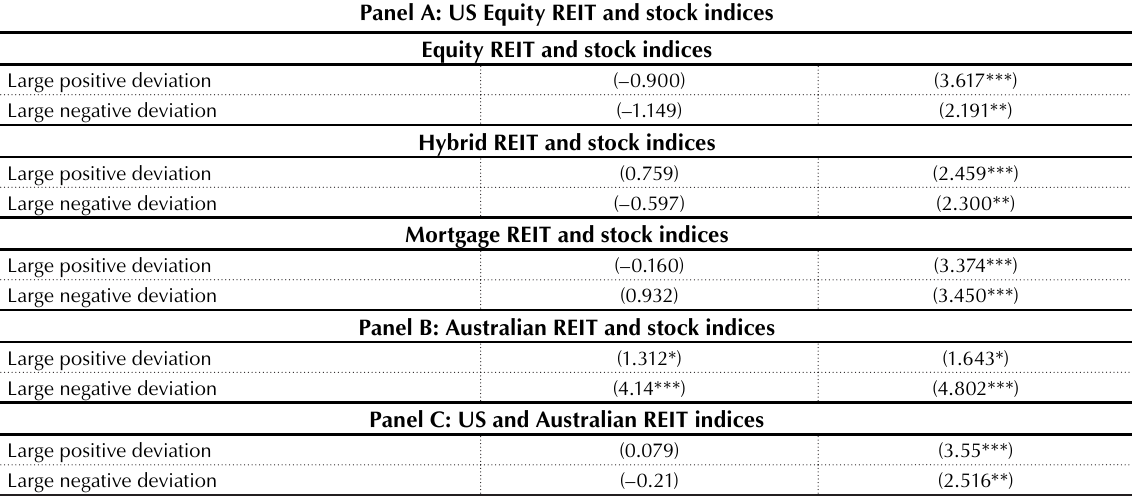
Table 6. Results of the nonlinear Granger causality test Panel A: US Equity REIT and stock